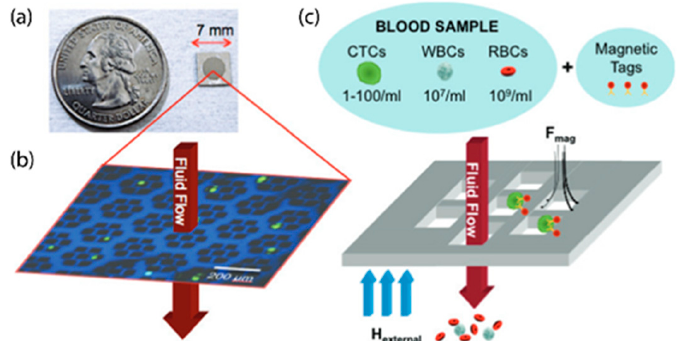
Figure 8. Magnetic cell sifter. ( a ) Image of the sifter. ( b ) Optical micrograph of the pore array and the trapped CTCs (green). ( c ) Operational principle. Immunomagnetically labeled CTCs are immobilized by the high magnetic gradient on the edges of the pores while other cells pass unaffected. Reproduced with permission [73]. Copyright 2021 RSC.